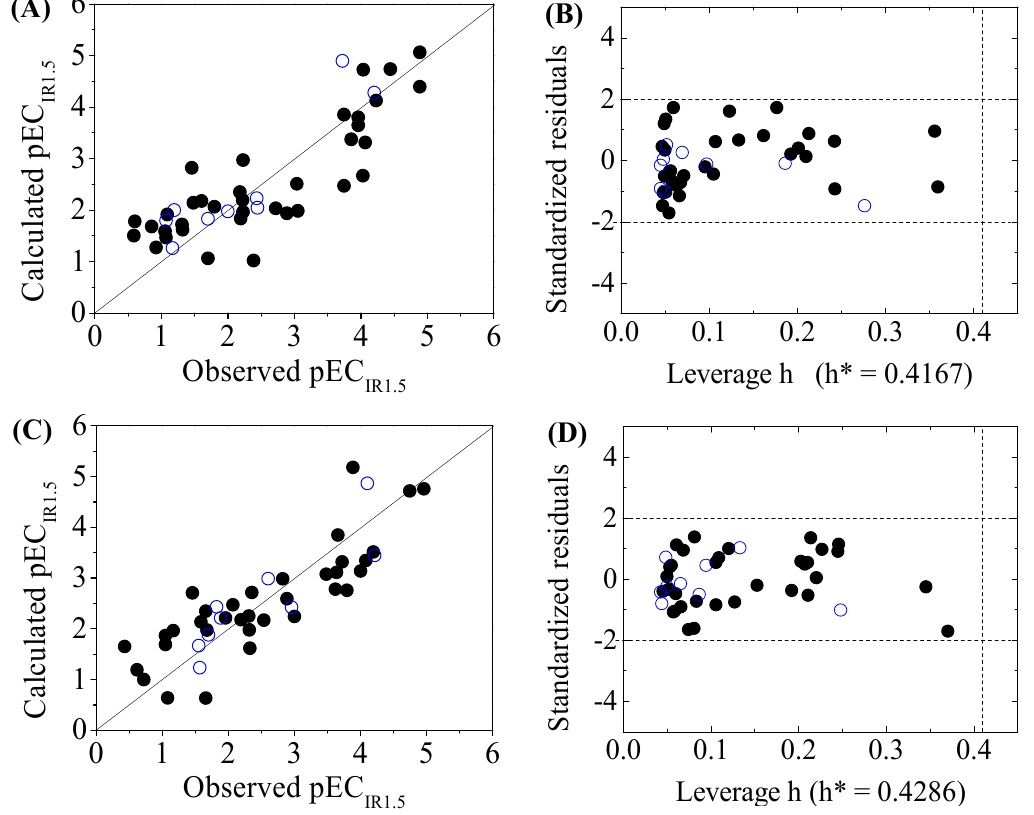
Figure 3. Scatter plot of observed versus calculated pEC IR1.5 (( A ) for DNA+ and ( C ) for DNA − ) and the Williams plot (( B ) for DNA+ and ( D ) for DNA − ) of the final model for 45 disinfection byproducts. “ ● ”: training set, “ ○ ”: test set.